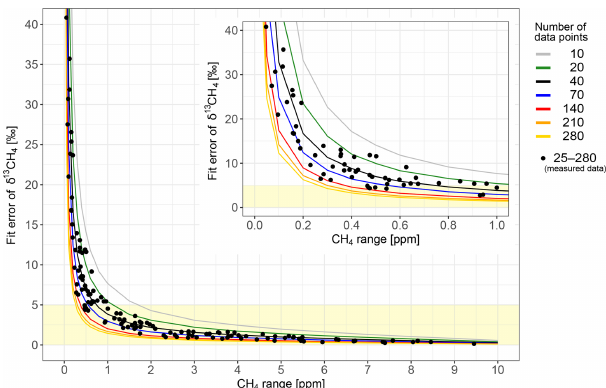
Figure 5. Dependency between peak height above background and error of the δ 13 CH 4 signature from the corresponding measured peaks. The inserted figure shows an enlarged section with CH 4 ranges up to 1ppm. The measured δ 13 CH 4 signatures with errors below 5‰ (data points within yellow shaded area) are used in this study. The lines show simulated data with different numbers of data points used in the Miller–Tans